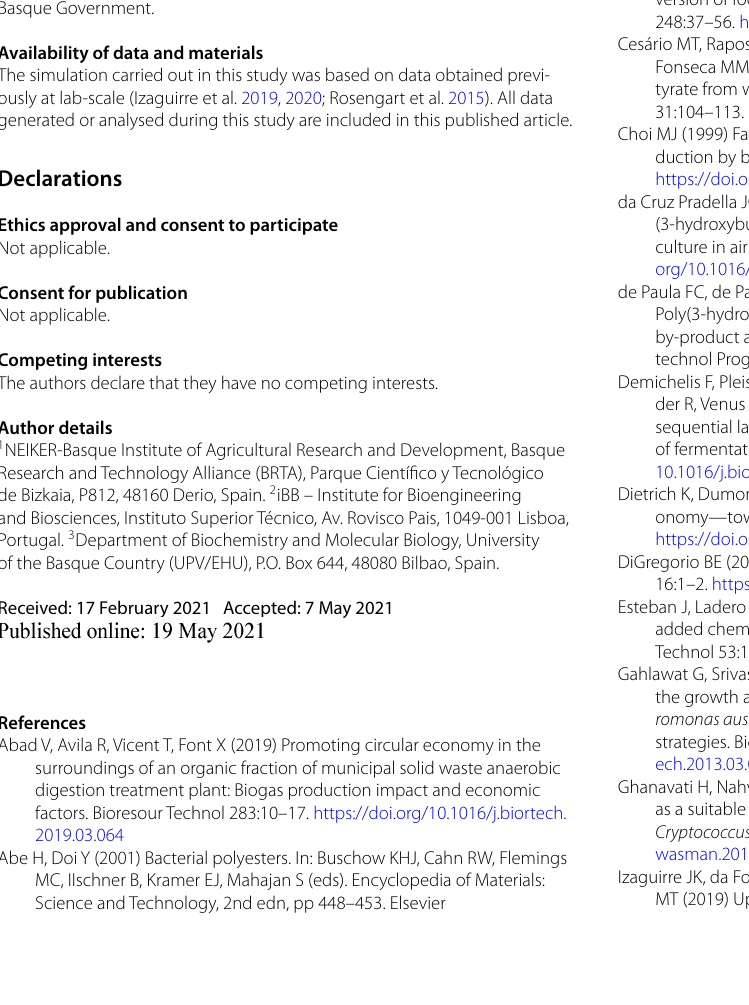
Additional Figure 1. Flowsheet of the bacterial P3HB production process in Scenario 1. Green: thermo-chemical pre-treatment and enzymatic hydrolysis. Blue: bacterial process. Orange: extraction-separation. Additional Figure 2. Flowsheet of the bacterial P3HB production process in Scenario 2. Green: thermo-chemical pre-treatment and enzymatic hydrolysis. Blue: bacterial process. Orange: